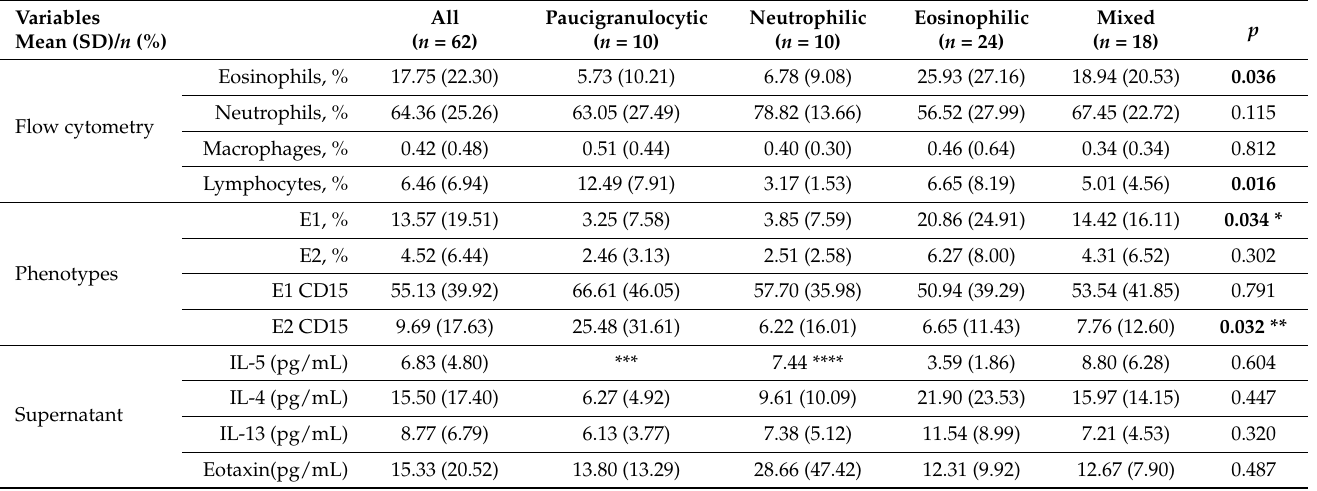
Table 2. Flow cytometry results: eosinophil populations, phenotypes, and cytokines in induced sputum